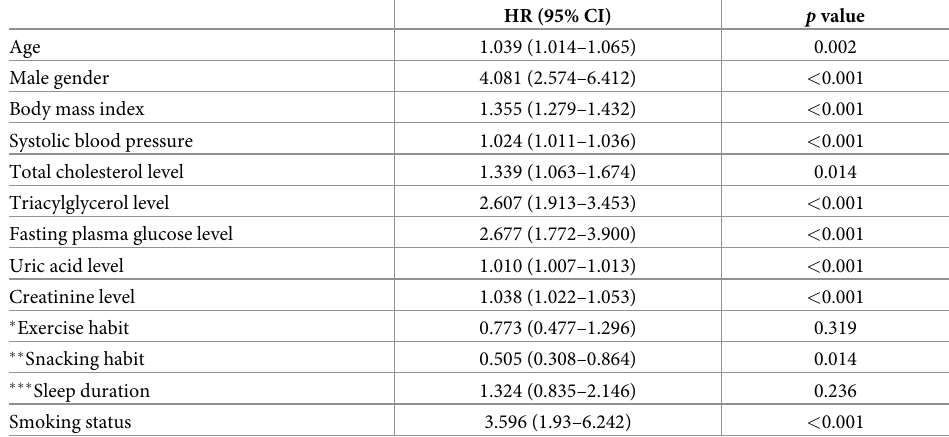
Table 3. Univariate analysis of the risk factors associated with the onset of fatty liver disease in the nondrinker group.